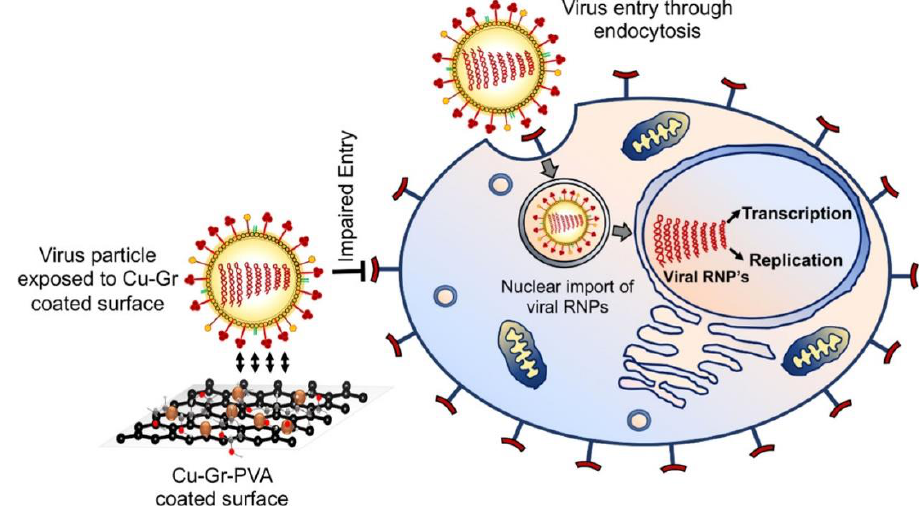
Figure 7. Mechanism of action of Cu-Gr coating on antiviral surfaces. (Printed image with permission from Ref. [118], copyright 2020, American Chemistry Society).